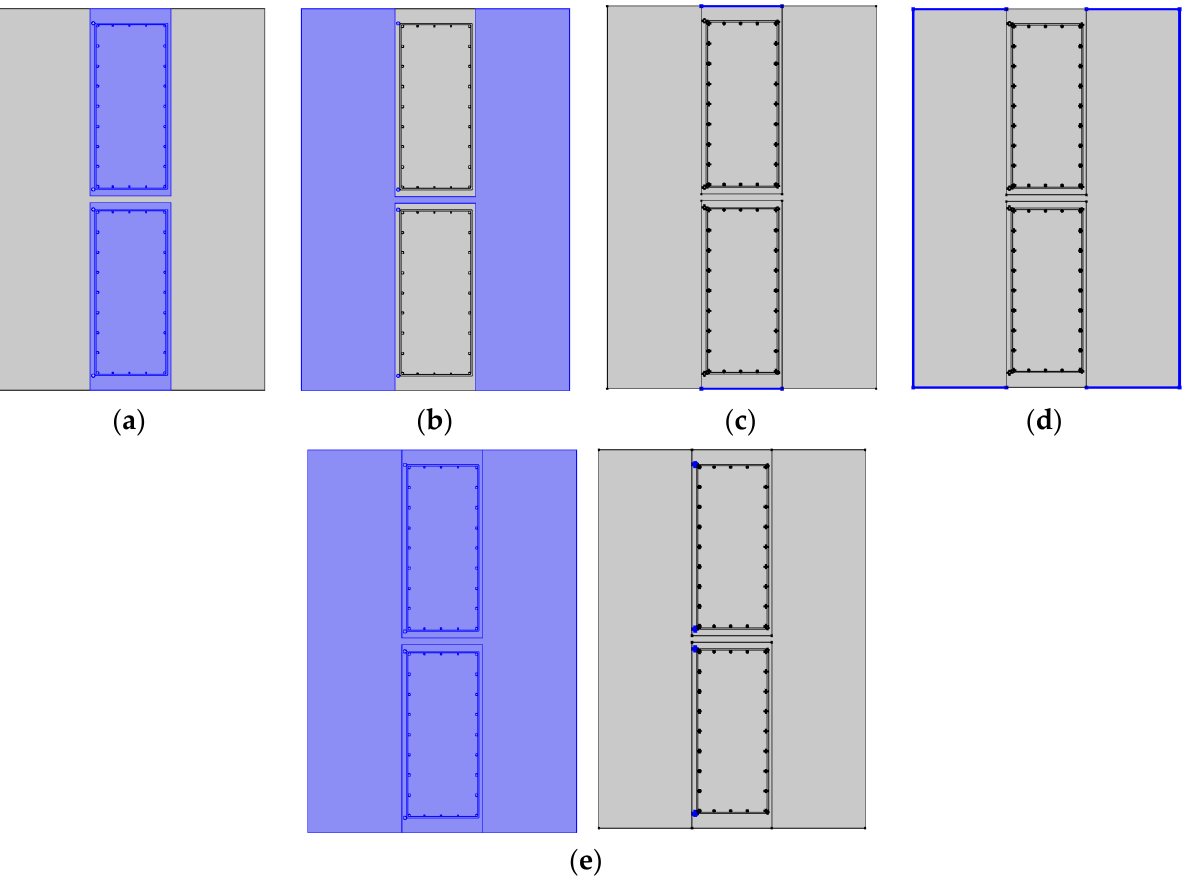
Figure 18. The heat transfer interface; ( a ) Wall heat transfer; ( b ) Soil heat transfer; ( c ) Insulating thermal field; ( d ) Open thermal field; ( e ) Initial temperature field.